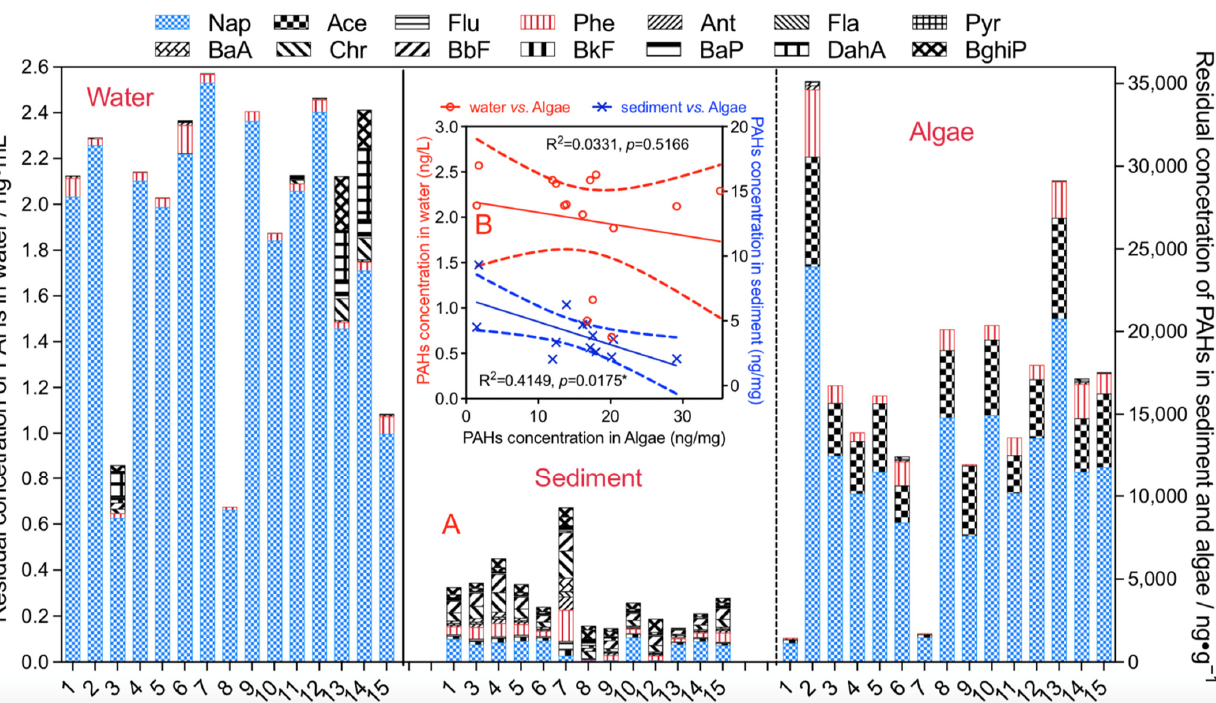
Figure 3. The residual characteristics of PAHs in water, sediment, and algae ( A ) and the correlation of PAHs concentration among algae, water, and sediment ( B ). Note: naphthalene (Nap), phenanthrene (Phe), anthracene (Ant), fluorene (Flu), fluoranthene (Fla), pyrene (Pyr), acenaphthylene (Ace), chrysene (Chr), benzo[a]anthracene (BaA), benzo[b]fluoranthene (BbF), benzo[k]fluoranthene (BkF), benzo[a]pyrene (BaP), dibenzo[a,h]anthracene (DahA), and benzo[g,h,i]perylene (BghiP). *: linear correlation is significant at the 0.0175 level.